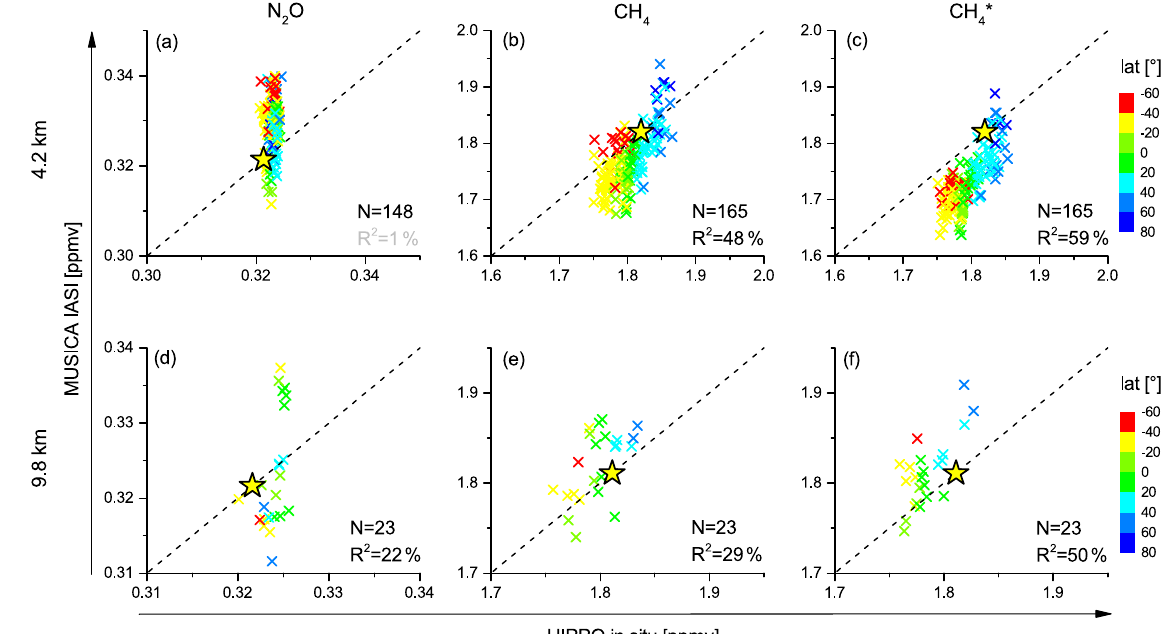
Figure 8. Correlation plots between MUSICA IASI products and HIPPO data: (a–c) for the altitude of 4.2kma.s.l.; (d–f) for the altitude of 9.8kma.s.l.; (a) and (d) for N 2 O; (b) and (e) for CH 4 ; and (c) and (f) for CH ∗ . The colour code indicates the latitudinal region, the yellow 4 star represents the a priori data used for the retrievals and the black dashed line is the one-to-one diagonal. Number of considered HIPPO profiles ( N ) and R 2 values are given in each panel, black colour indicates significant positive correlations (95% confidence level) and grey indicates no significance.